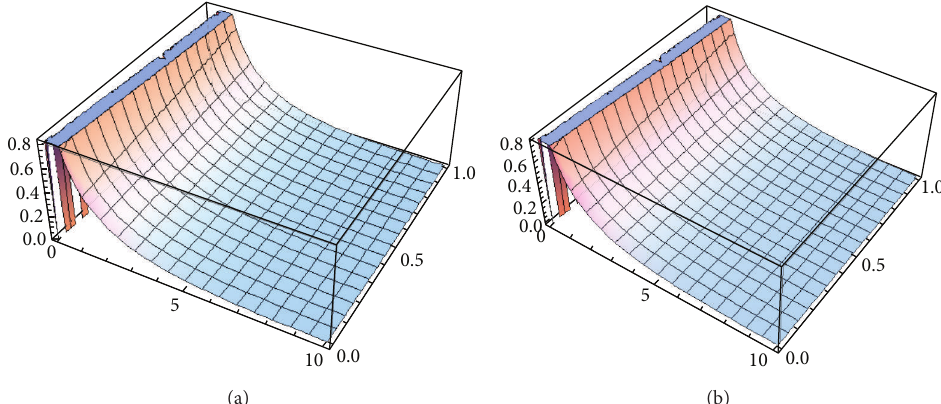
Figure 1: Graph of the solution (21) corresponding to the values 𝛼 = 0.05 , 𝛼 = 0.85 , respectively, when 𝑘 = 1 , 𝑝 = 2 , 𝑎 1 = 1 , 𝑏 0 = 2 , 𝛽 = 3 , 0 < 𝑥 < 10 , and 0 < 𝑡 < 1 .